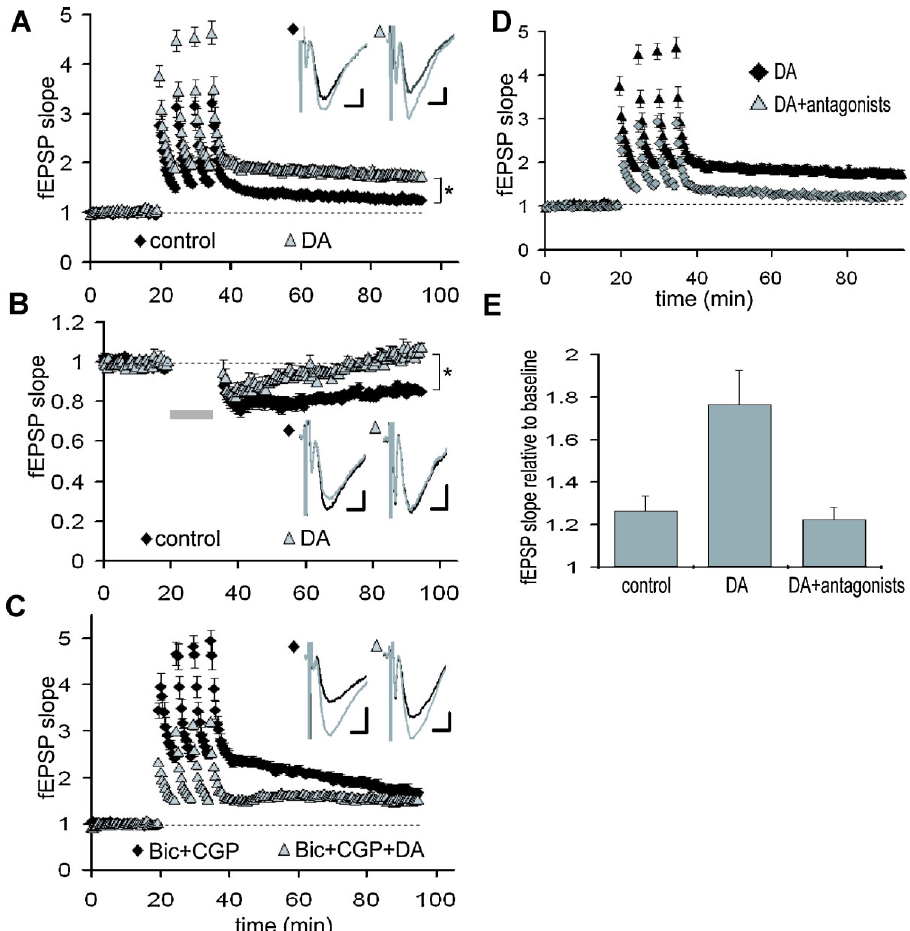
Figure 7. DA-induced modulation of synaptic plasticity at TA-CA1 synapses . ( A ) Enhancement of TA-CA1 LTP by DA. DA was present for the duration of the experiment. Baselines are normalized to 1.0 in order to examine LTP independent of the depression of basal synaptic transmission by DA. For all traces, the baseline (preplasticity) trace is black, the post-plasticity trace is gray. p<0.01 (control: n = 7, DA: n = 8). Scale bar = 0.1mV, 5ms. ( B ) Attenuation of TA-CA1 LTD by DA. Gray bar: LTD induction. p<0.01 (control: n = 7, DA: n = 6). Scale bar = 0.1mV, 5ms. ( C ) Occlusion of DA-induced TA-CA1 LTP enhancement under GABA AandB receptor blockade. Under GABA receptor blockade, DA did not significantly enhance LTP (n = 5 for each group). Scale bar = 0.1mV, 5ms. ( D ) Blockade of DA-induced enhancement of TA-LTP by DA receptor antagonists, SKF 83566 (1 µ M) and Sulpiride (10 µ M) (DA: n = 8, DA antagonists: n = 5). ( E ) Analysis of LTP at TA-CA1 synapses (50–60minute after LTP induction). DA receptor antagonists completely blocked DA-induced enhancement of TA-LTP (control: n = 7, DA: n = 8, DA antagonists: n =